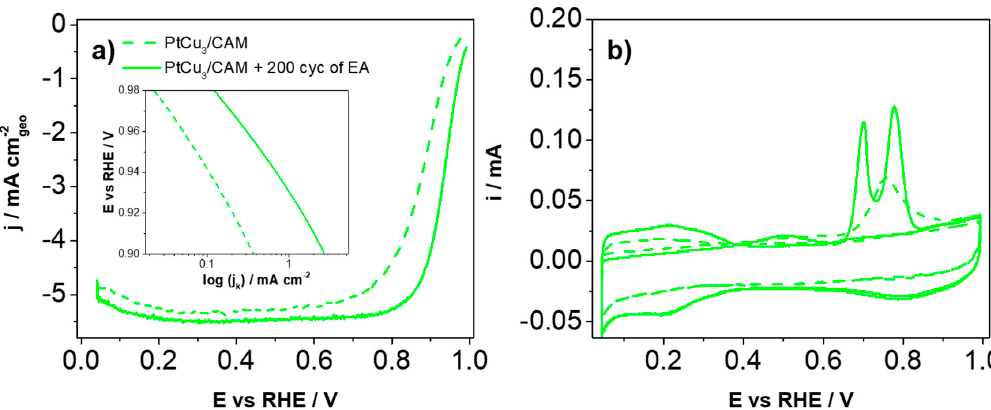
Figure 2. ( a ) ORR anodic polarization curves and Tafel plots as well as ( b ) CO electrooxidation of the PtCu 3 /CAM analogue directly after immersion in the electrolyte (dashed), and after 200 additional cycles of EA (0.05–1.2 V RHE , 300 mV s − 1 ).